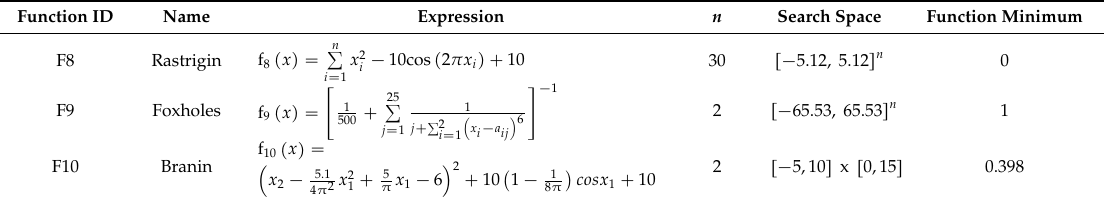
Figure 10. Convergence characteristic curves for QLSA, LSA, BSA, GSA and PSO in: ( a ) F4; ( b ) F5; ( c ) F6; ( d ) F7. Table 7. Multimodal and separable test functions.